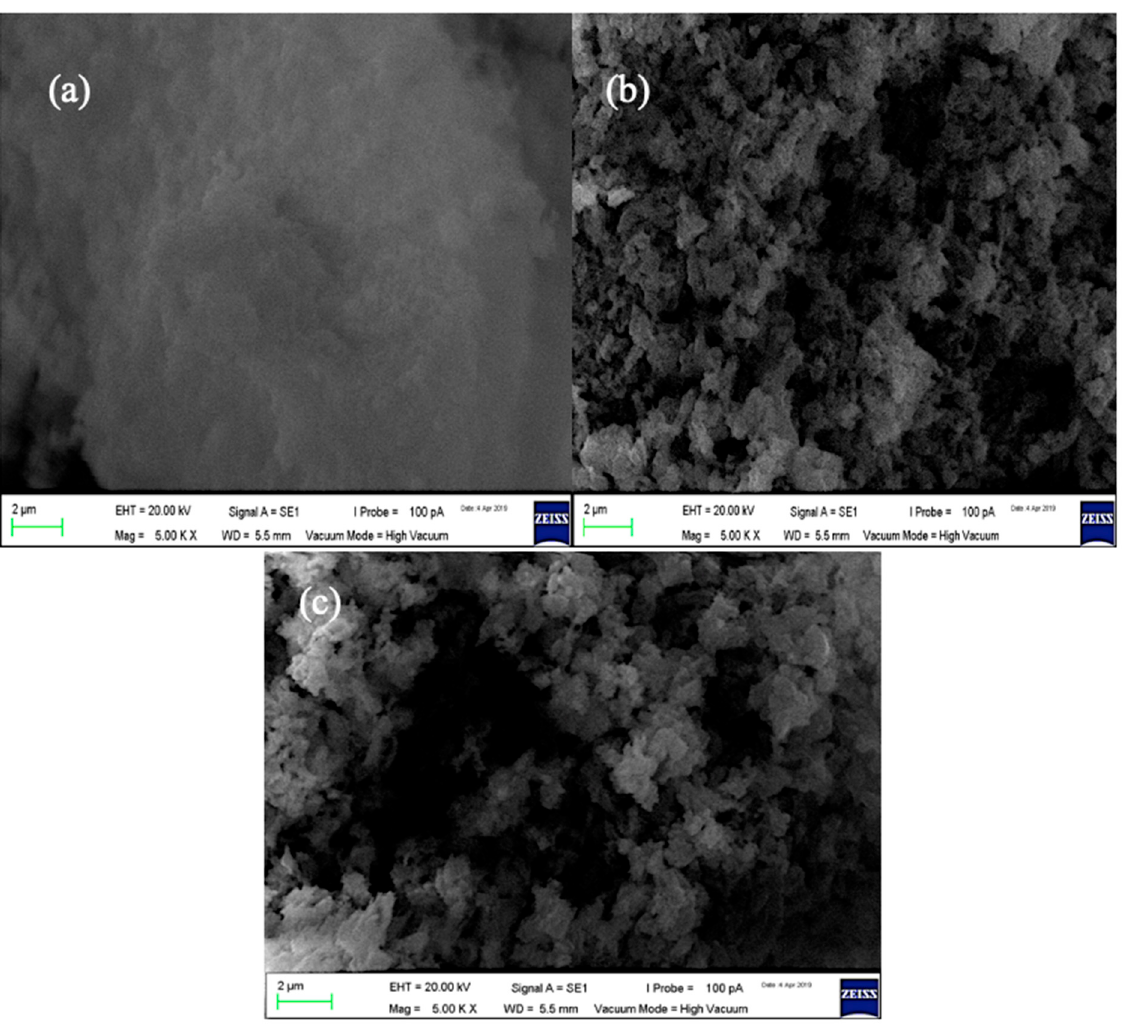
Figure 2. SEM of Chitosan ( a ) 5 wt.% ZnO-chitosan ( b ) 10 wt.% ZnO-chitosan ( c ) at 1 K and 5 K magnifications, respectively.